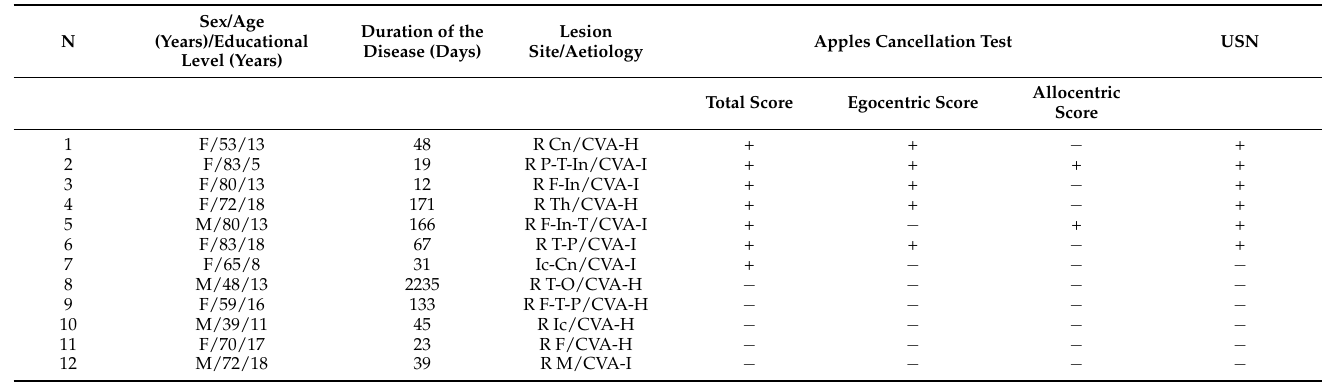
Table 1. Patients’ demographic and clinical features. Lesion aetiology (I: ischemic; H: haemorrhagic). Lesion site (F: Frontal; P: Parietal; T: Temporal; O: Occipital; Ic: Internal Capsule; In: Insula; Cn: Caudate Nucleus; Th: Thalamus. R: right. +/ − = presence/absence of